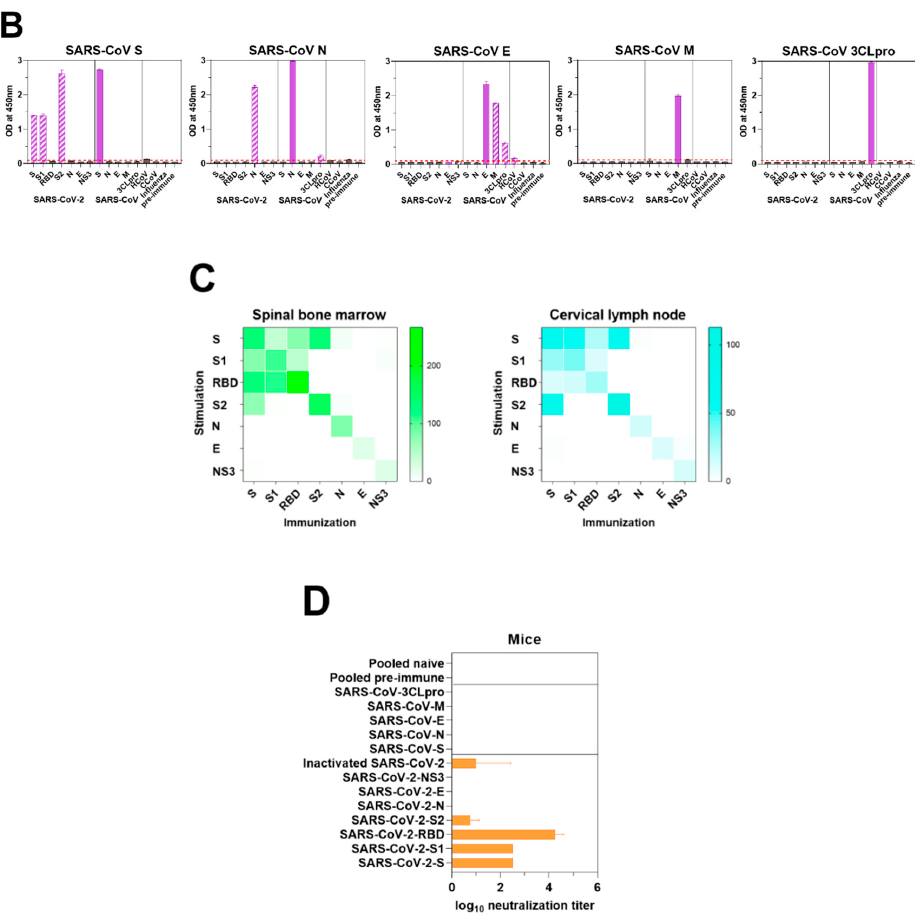
Figure 3. Immune responses of mice to SARS ‐ CoV ‐ 2. ( A ) Viral protein ‐ specific IgG antibody responses of mice immunized with S, S1, RBD, S2, N, E, or NS3 of SARS ‐ CoV ‐ 2. Viral protein ‐ specific IgG responses of murine sera and cross ‐ reactivities to the viral proteins of SARS ‐ CoV, CCoV 1 ‐ 71, HCoV NL63, and influenza virus were measured by ELISA. Blue bars represent homologous antibody responses, and bars with slash lines display cross ‐ reactive antibody responses. Red lines are the cut ‐ offs calculated as 3 times the mean absorbance value of the preimmune sera. ( B ) Antibody response was measured in mice immunized with S, N, E, M, or 3CLpro of SARS ‐ CoV. Purple bars show homologous antibody responses, and bars with slash lines represent cross ‐ reactive antibody responses. ( C ) S ‐ , S1 ‐ , RBD ‐ , S2 ‐ , N ‐ , E ‐ , and NS3 ‐ specific IgG PCs in spinal bone marrow (left) and ASCs in cervical lymph nodes (right) were quantified ex vivo in ELISpot assays. Bone marrow and lymph node cells were obtained from the mice immunized with respective viral protein of SARS ‐ CoV ‐ 2. ( D ) The presence of neutralizing antibodies in mice immunized with S, S1, RBD, S2, N, E, or NS3 of SARS ‐ CoV ‐ 2; inactivated whole virus of SARS ‐ CoV ‐ 2; and S, N, E, M, or 3CLpro of SARS ‐ CoV was measured by in vitro neutralization assays using a pseudotyped virus. The transduction efficacy was determined by measuring the luciferase activity. Nonlinear regression analysis was used to obtain the IC 50 in the neutralization